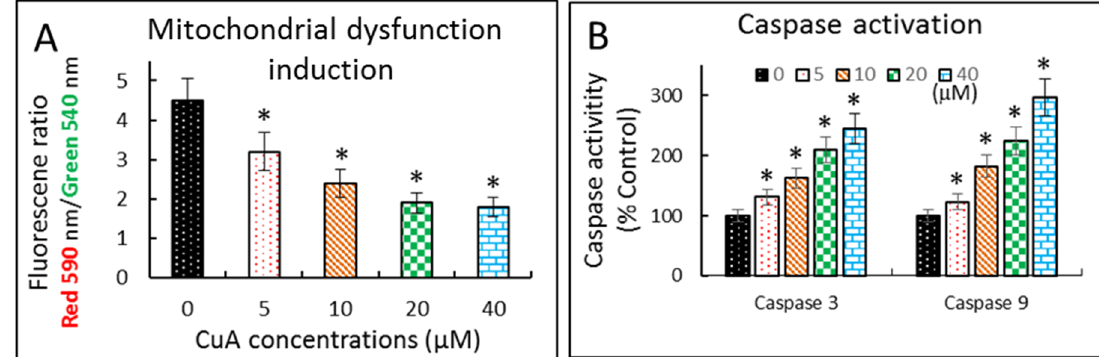
Figure 4. Cuminaldehyde caused apoptosis via the mitochondrial pathway in human colorectal COLO 205 cells. ( A ) Cells were treated with the specified cuminaldehyde concentrations for 48 h and mitochondrial membrane potential was evaluated using JC ‐ 1 spectrophotometrically; ( B ) Activations of caspase ‐ 3 as well as ‐ 9. After treating the cells using the specified concentrations of cuminaldehyde for 48 h, activities of caspases ‐ 3 and ‐ 9 were determined using a spectrophotometer. Results are expressed by means plus/minus standard error of the mean, n equal to 3. *, Statistically significant ( p less than 0.05) from the control group. CuA, cuminaldehyde.